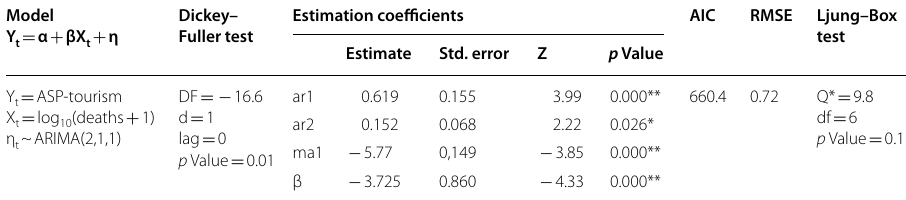
Table 3 Result of the dynamic regression model: explanatory variable “cumulative number of deaths”